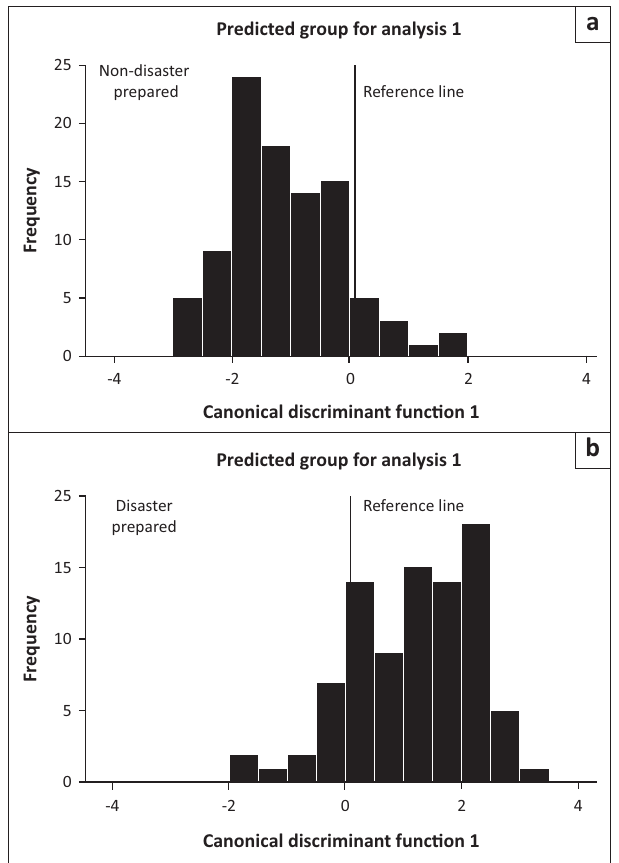
FIGURE 2: Distribution of discriminant scores for disaster prepared and nonprepared